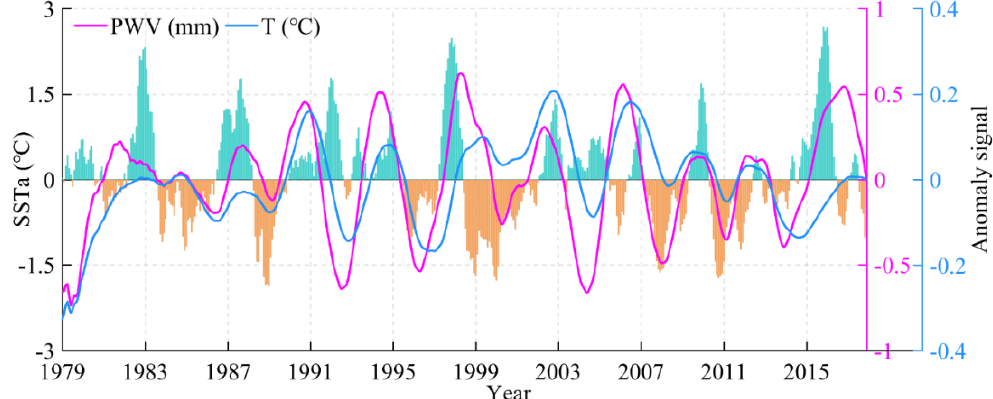
Figure 7. Time series of anomalous variations of PWV and T with SSTA over the period of 1979 – 2017 in southeast China.